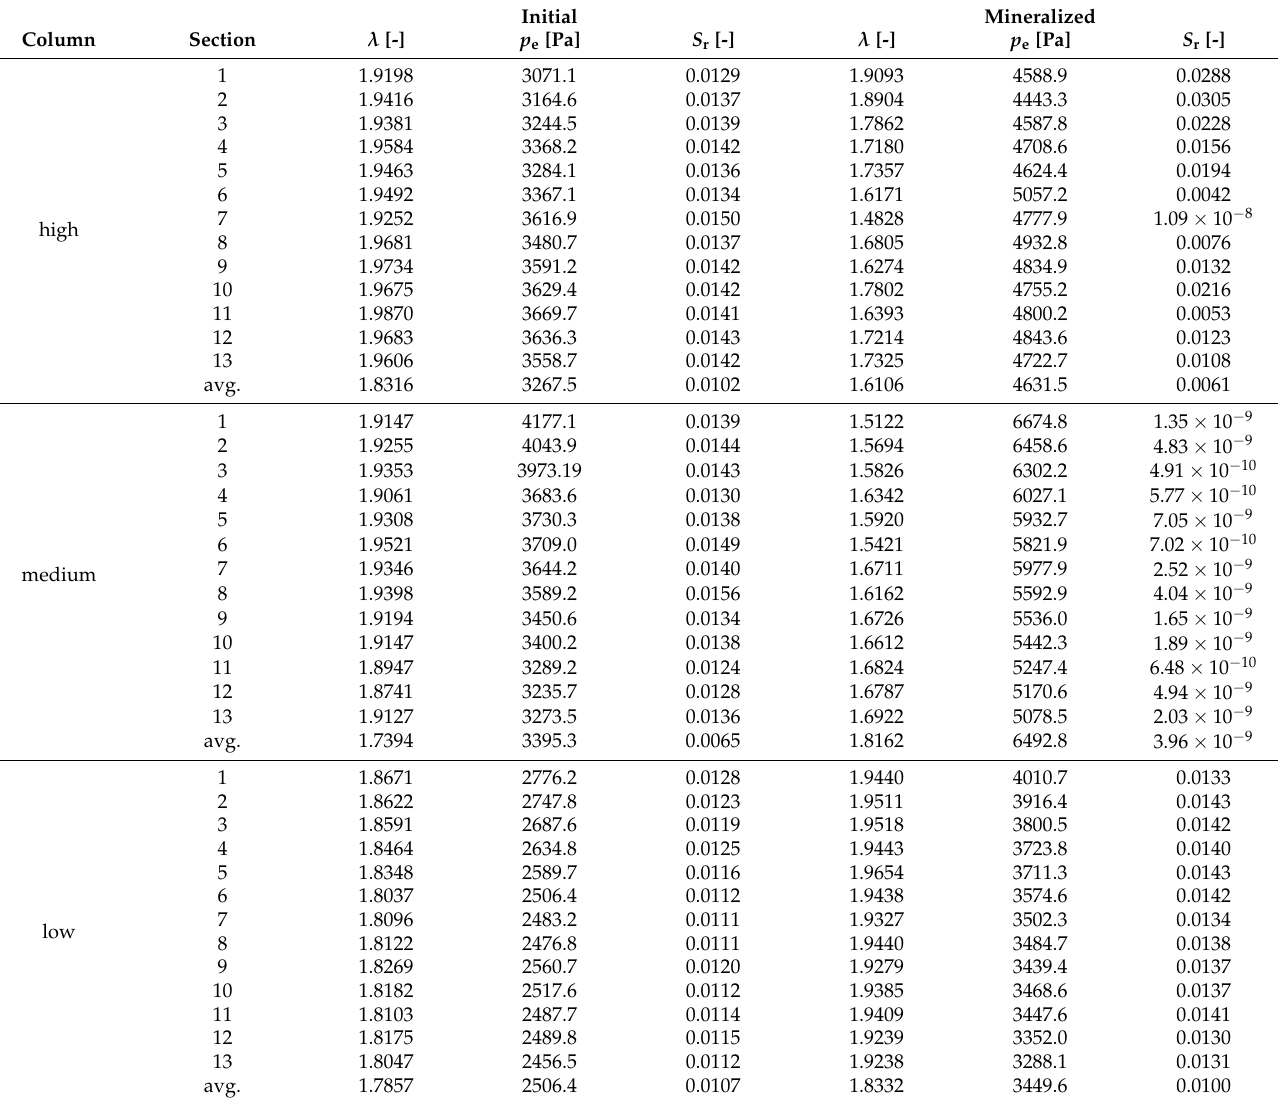
Table 5. Parameters of the Brooks–Corey capillary pressure–saturation relation (Equation (4)) for the initial and mineralized 3D experiments as fitted to each of the 13 sections along the column